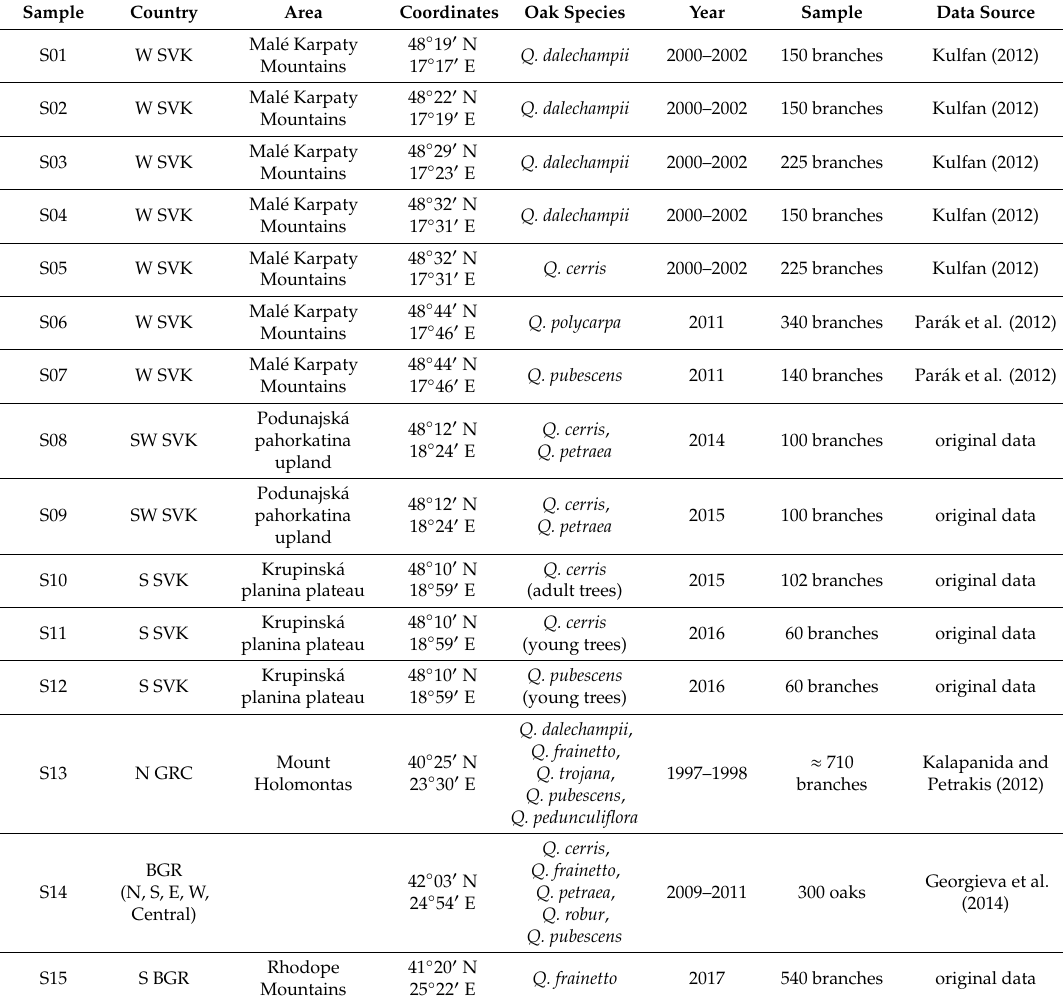
Table 1. Survey of sampling caterpillar assemblages on oaks in Slovakia (SVK), Bulgaria (BGR) and Greece